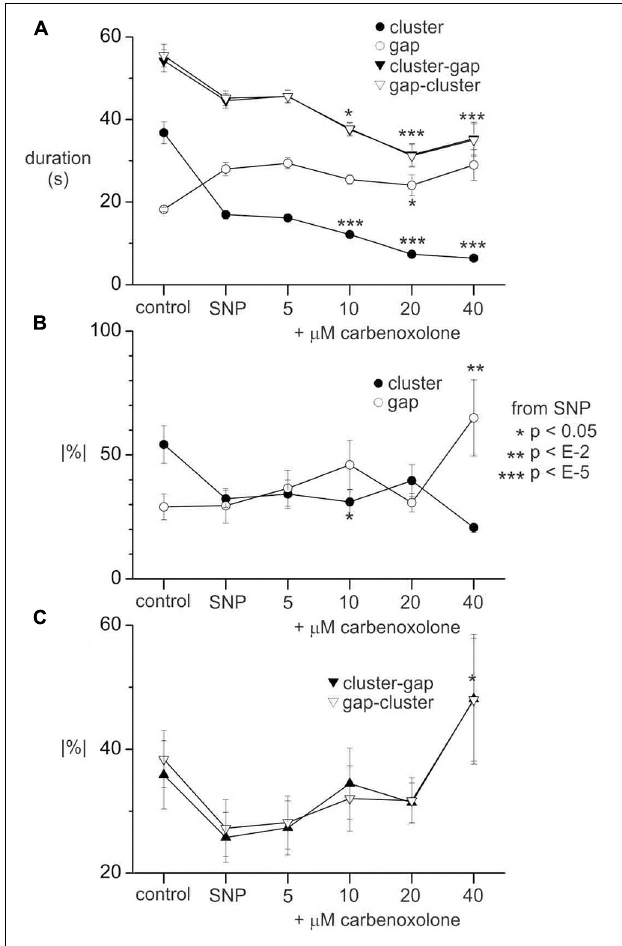
FIGURE 9 | Effect of carbenoxolone on clusters and gaps in the presence of SNP. (A) Cluster, gap and cycle (cluster-gap or gap-cluster) durations without SNP (control), with 1 µ M SNP and after incrementing carbenoxolone to various concentrations as indicated. (B) Absolute percentage change in duration from cluster to cluster or gap to gap. (C) Absolute percentage change in duration from cycle to cycle. All values are means ( standard error for data from six intestines. n’s (number of clusters, gaps or cycles) range from 46 to 104 and are not shown for clarity. p values are by Mann Whitney rank sum z -test between SNP and carbenoxolone. In panel (A) p values are not shown for gap-cluster cycles for clarity. p values for control against SNP are also not shown for any of the graphs. The same p scale shown to the right of panel (B) applies to all graphs.